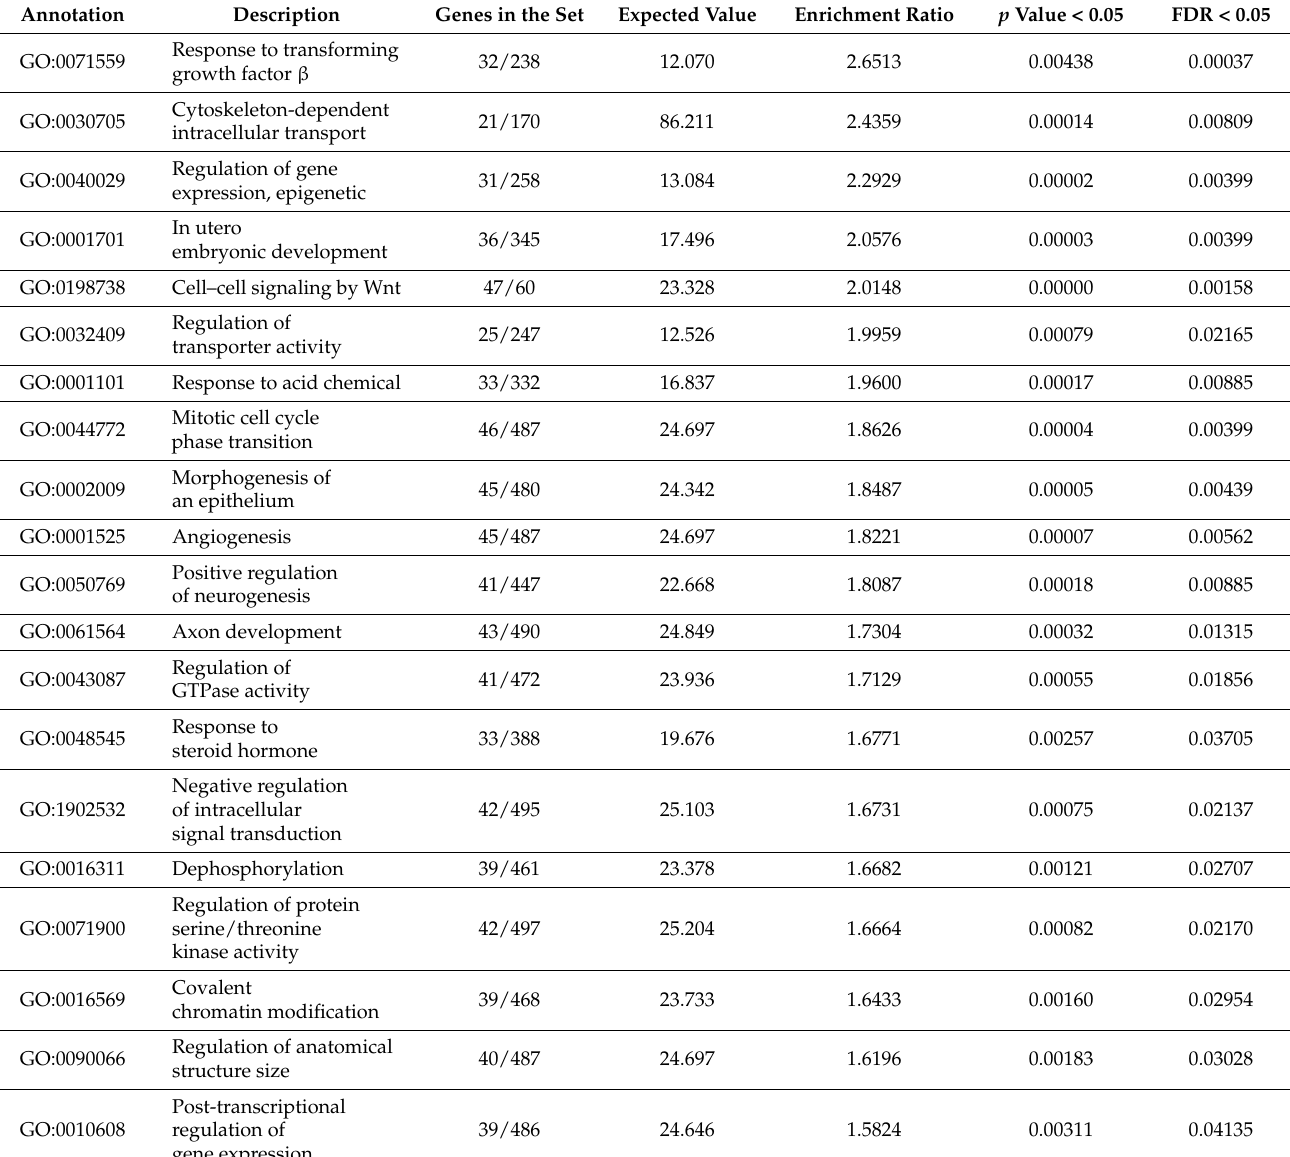
Table 2. The gene ontology (GO) annotations derived from genes targeted by miRNAs detected in serum from RCD2 patients. The analysis was post-processed using a weighted set cover method to reduce redundancy. The GO are listed with respect to the enrichment